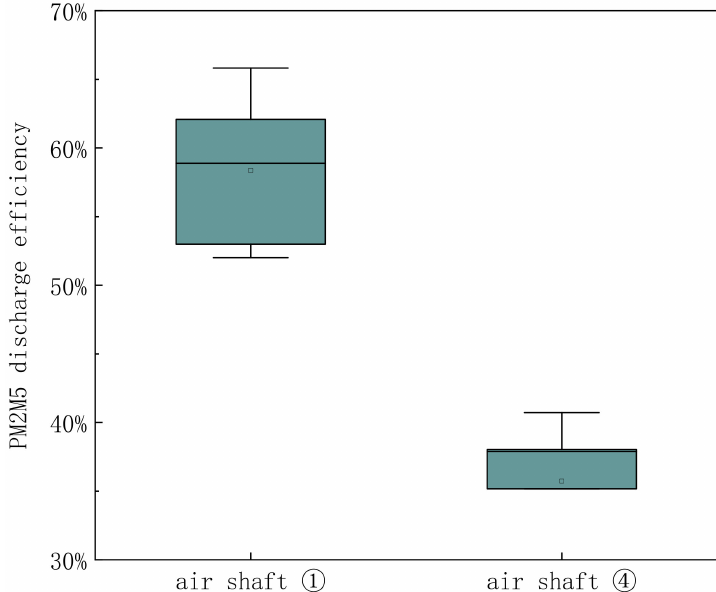
Figure 13. PM2.5 discharge efficiency of air shaft 1 (cid:13) and air shaft 4 (cid:13)